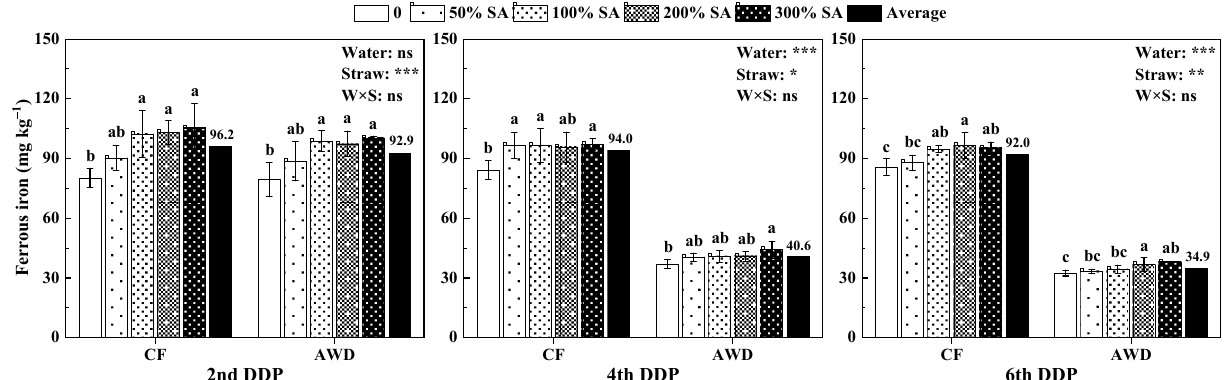
Figure 5. Soil total reductant content under different water management regimes and straw addition rates. Different letters indicate significantly different at p < 0.05 under the same water management regime. Data in the figures indicate means of three replicates ± standard deviation. *** means p < 0.001; ns means non ‐ significant. CF, continuous flooding irrigation; AWD, alternate wetting and drying irrigation; SA, straw addition rate. DDP, day of the drying period.